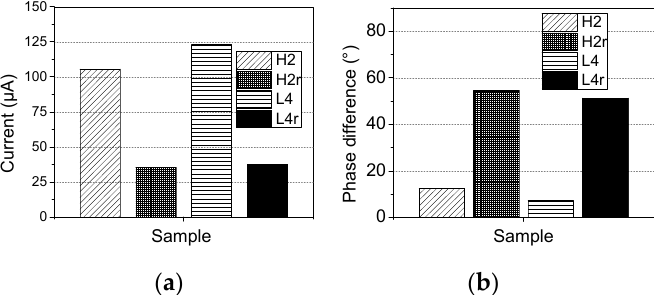
Figure 21. Comparison of the current and phase difference of samples H2 and L4 before and after the removal of the surface layer: (a) Current; (b) Phase difference.